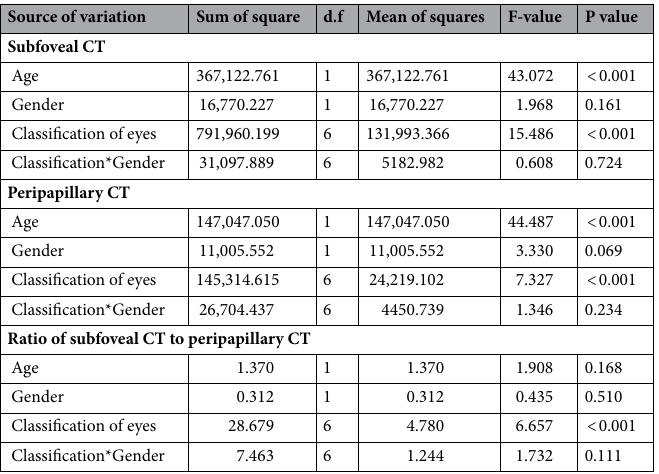
Source of variation Sum of square d.f Mean of squares F-value P